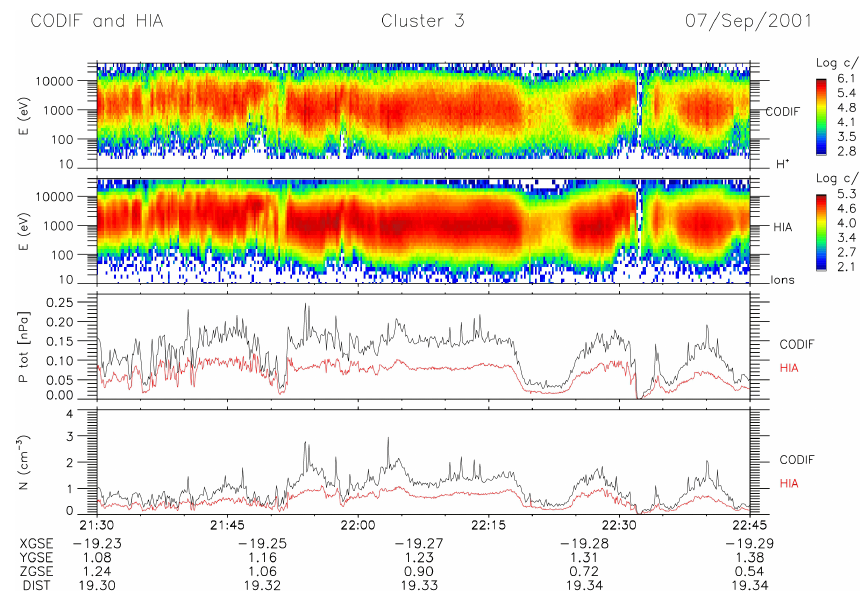
Fig. 9. CODIF and HIA data comparison in the plasma-sheet region. From top to bottom, the first two panels show the differential energy spectrogram from CODIF and HIA, respectively. The next two panels show the plasma pressure and plasma density as provided by CODIF (black line) and HIA (red